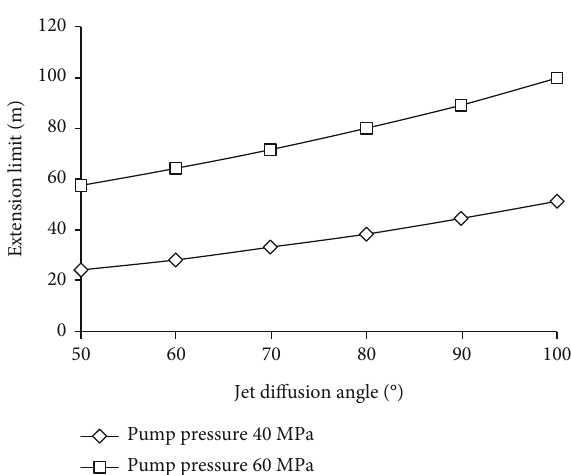
Figure 9: Extension limit in fl uenced by the backward nozzle